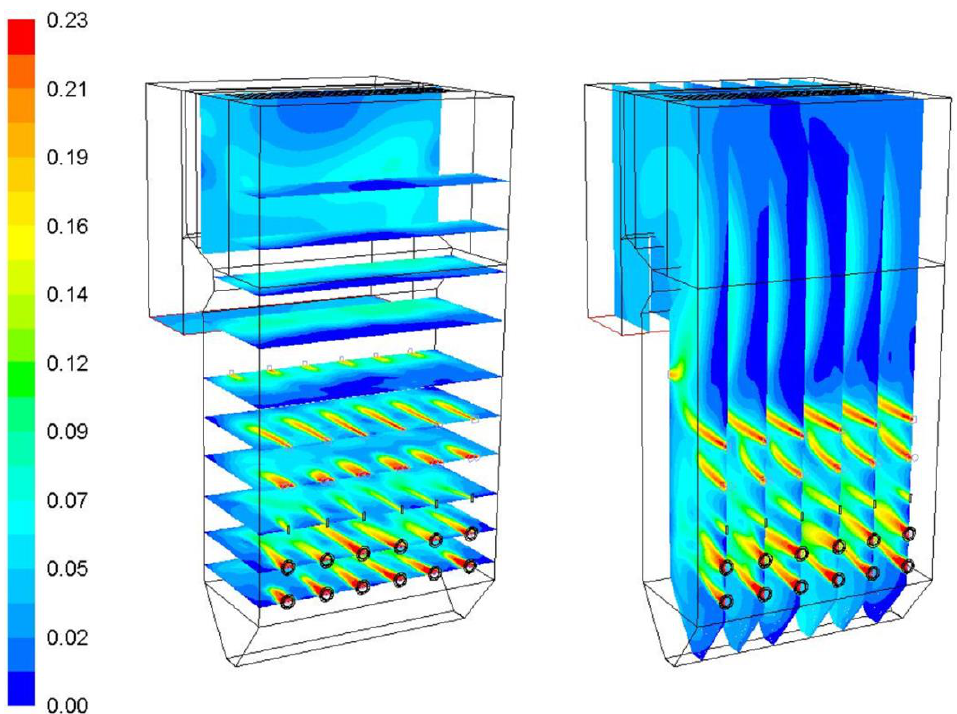
Figure 7. Temperature distribution (K) in the planes of the burner axis.